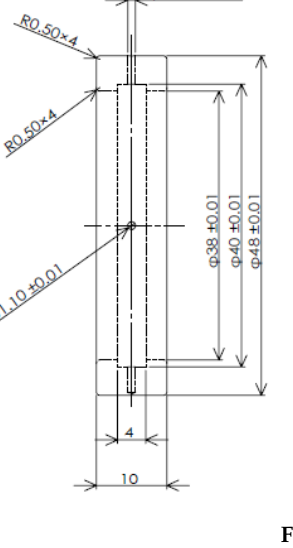
Figure 3. Measurement of specimens for cooling curves at the outer edge of the bearing. A and B are the location of the K-type thermocouple device.